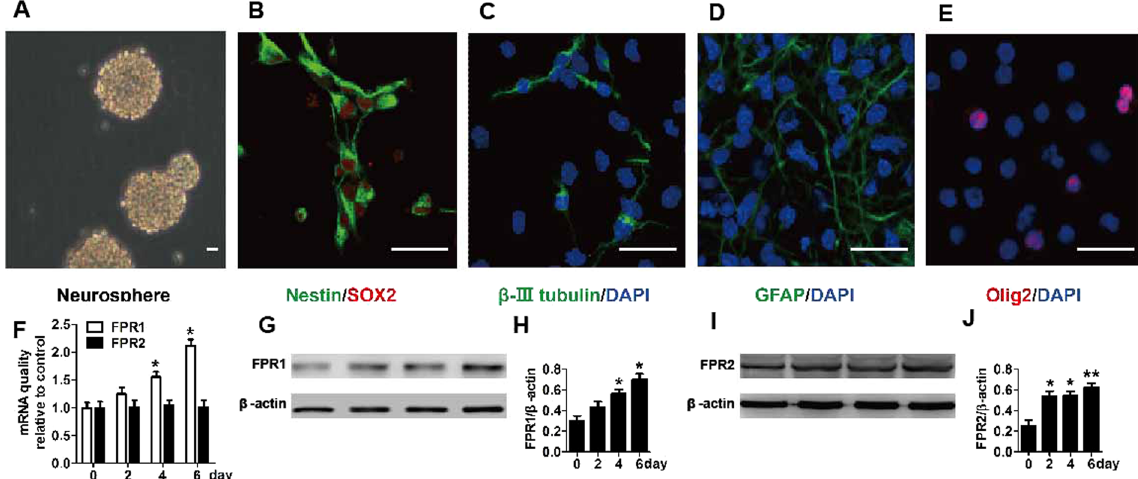
Figure 1. Characterization of neurospheres from cortices of fetal mouse pups and expression of FPRs significantly increasing during differentiation of mouse NSCs. ( A ) Phase contrast images of suspended neurospheres. ( B–E ) Confocal images of adherent cells. ( B ) NSCs labeled with SOX2 and Nestin. ( C–E ) Neurons, astrocytes, and oligodendrocytes. ( C ) β -III tubulin − labeled neurons with DAPI-counterstained nuclei. ( D ) GFAP-labeled astrocytes with DAPI-counterstained nuclei. ( E ) Olig2-labeled oligodendrocytes with DAPI-counterstained nuclei. ( F ) FPR1 and FPR2 mRNA expression during differentiation of mouse NSCs was evaluated by quantitative reverse transcription PCR. ( G ) Representative immunoblots for FPR1. ( H ) Histograms showing relative levels of FPR1. ( I ) Representative immunoblots for FPR2. ( J ) Histograms showing relative levels of FPR2. Data were presented as means ± SEM. * P < 0.05; N = 6. Scale bar = 20 µ